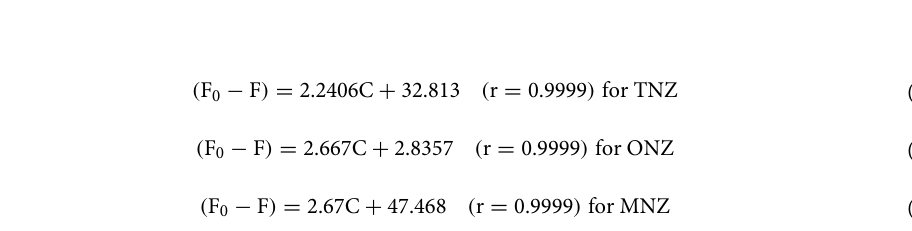
Table 2. Analytical performance data of the proposed